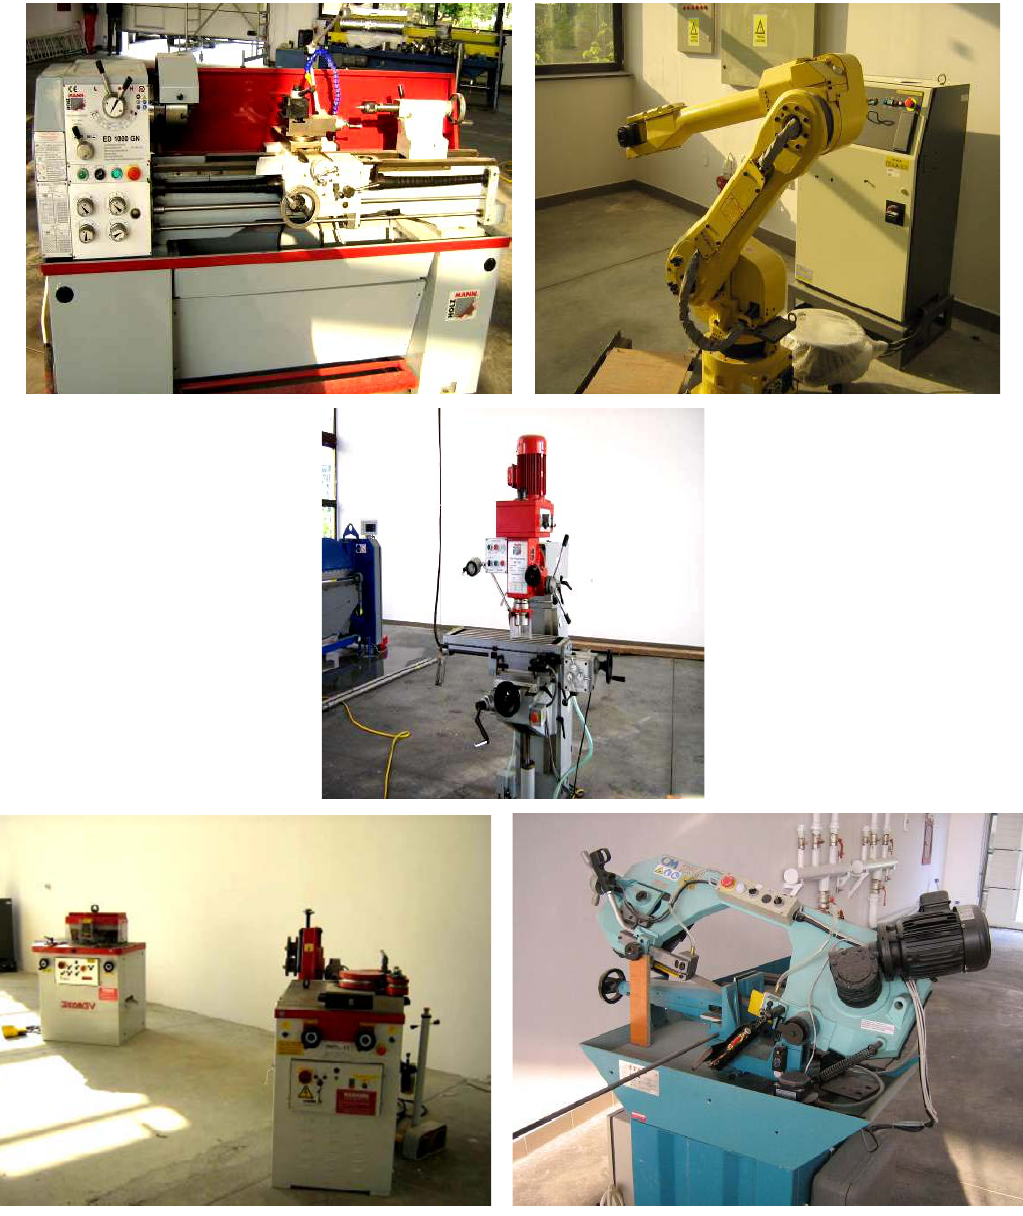
Figure 7. “Logistic support, performing machineries with great prototyping